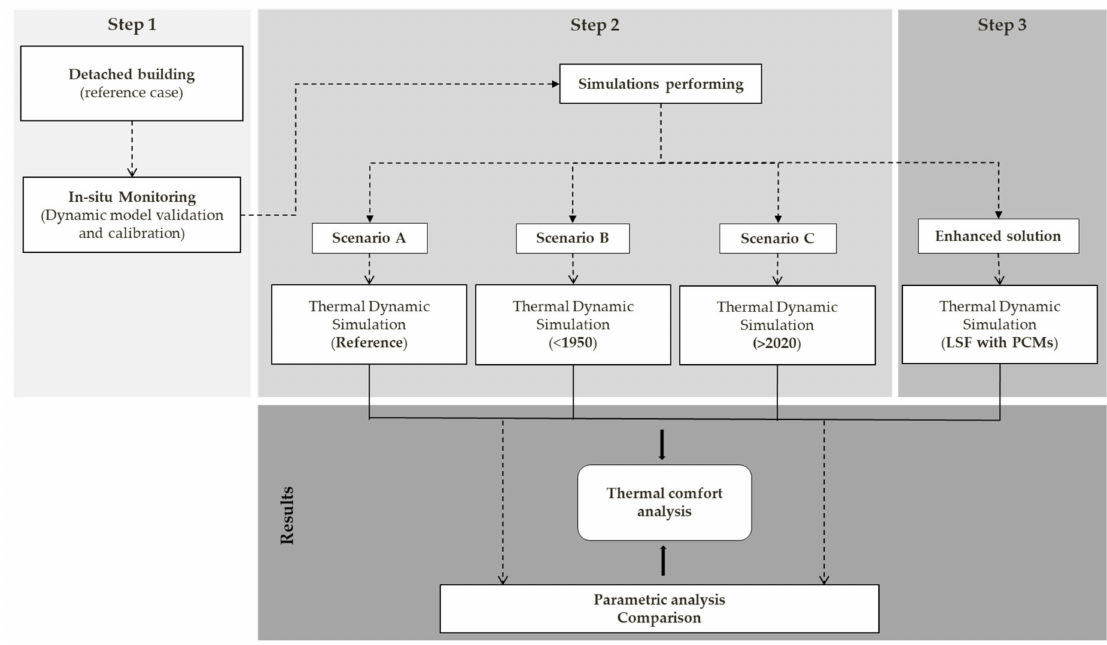
Figure 4. Schematic of the followed